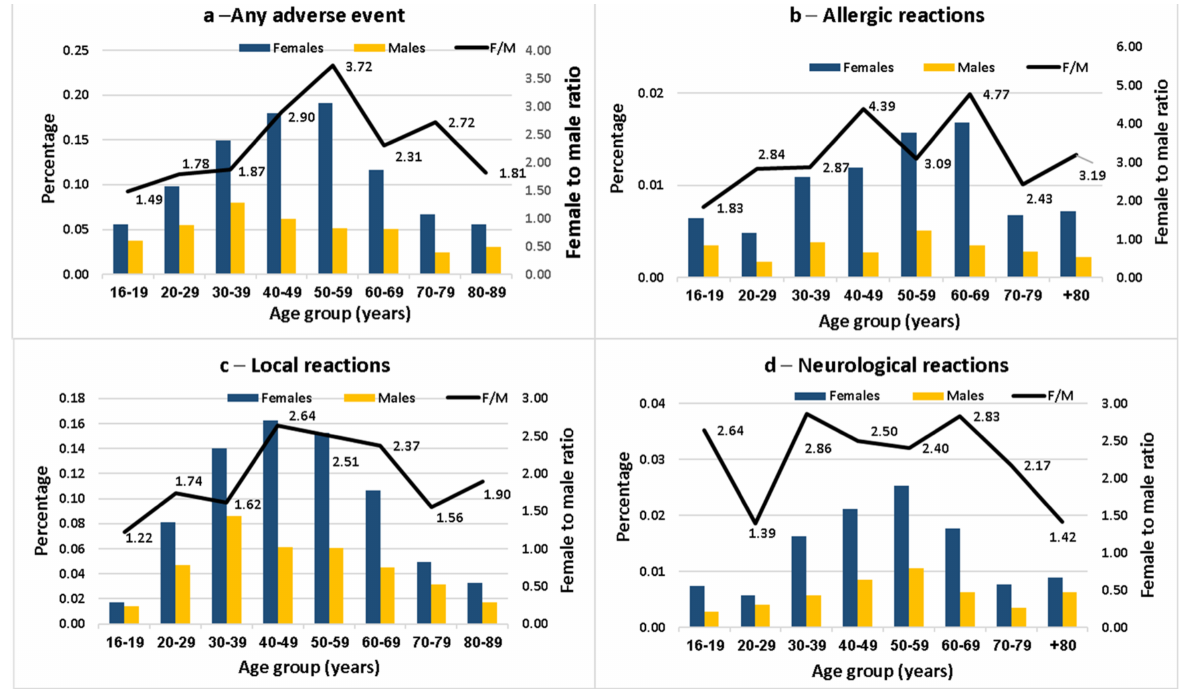
Figure 1. Female-to-male ratio of the percentage reporting adverse events after the first dose of the Pfizer-BioNTech COVID-19 vaccine in the Israel Ministry of Health database, by age